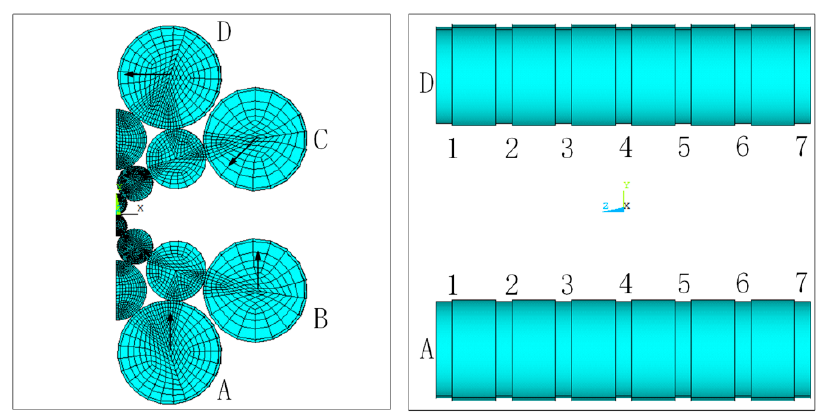
Figure 2. The diagram of the backup roll.